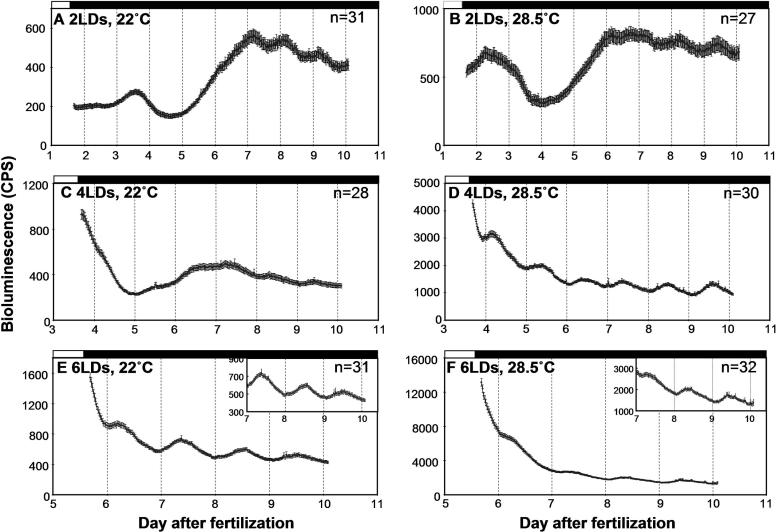
Effects of Temperature on Development of per3-luc ExpressionTransgenic embryos were entrained by two, four, or six LD cycles at either 22 °C or 28.5 °C, and monitored for bioluminescence in DD at 21–24 °C. (A) Two LDs at 22 °C, (B) two LDs at 28.5 °C, (C) four LDs at 22 °C, (D) four LDs at 28.5 °C, (E) six LDs at 22 °C, and (F) six LDs at 28.5 °C. The insets in (E) and (F) show the last 3 d of the record with magnified y-axis scales. Black and white bars on top of each plot represent the times when the lights were off and on, respectively. Actual amount of bioluminescence in cps is averaged and plotted in each graph. Number of animals that were averaged is given at top right corner of each plot. Error bars represent SEM. Results of one of two identical experiments with similar results are shown here.